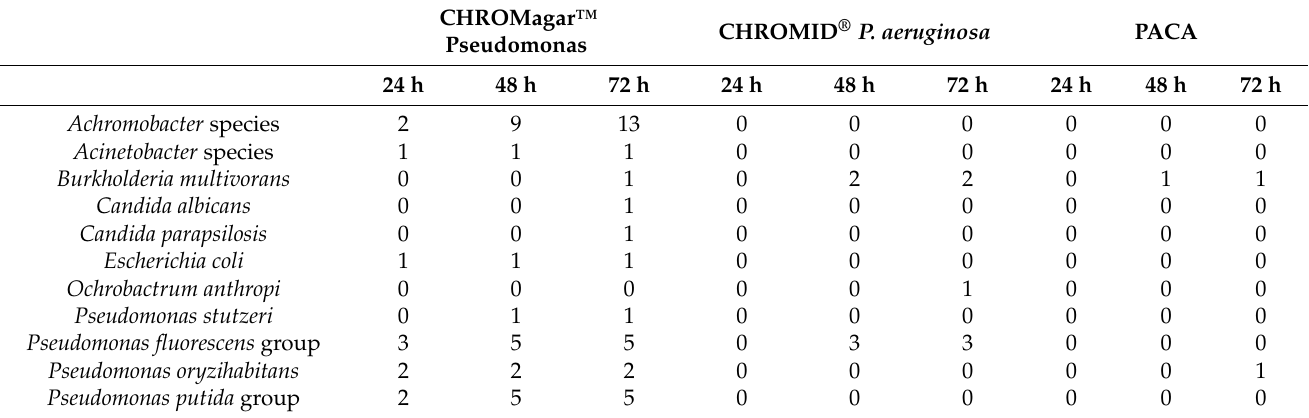
Table 1. Species incorrectly assigned as presumptive P. aeruginosa on three chromogenic media.